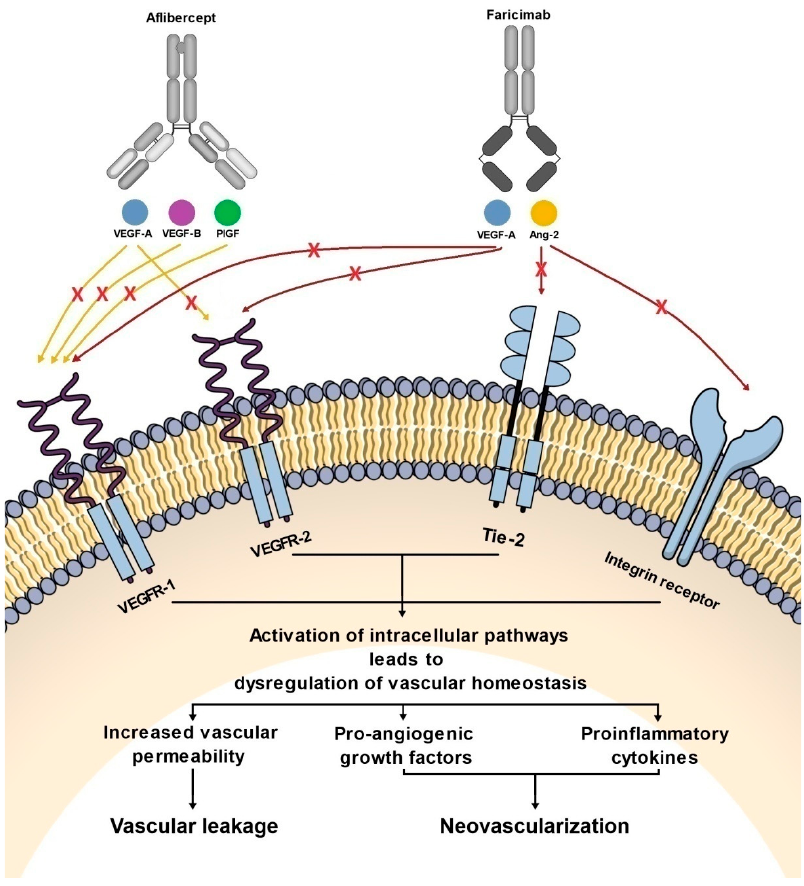
Figure 2. Diagram showing the effect of aflibercept and faricimab on pathways involved in the pathogenesis of nAMD and DME. pathogenesis of nAMD and